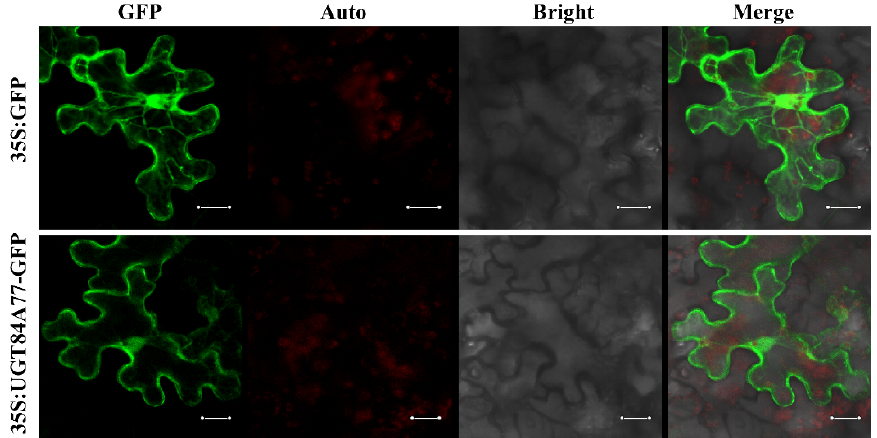
Figure 6. Subcellular localization of UGT84A77 in Nicotiana benthamiana leaves. GFP: GFP channel; Auto: chloroplast auto-fluorescence; Bright: light microscopy image; Merge: merged images of three channels. Scale bars represent 20 μ m.